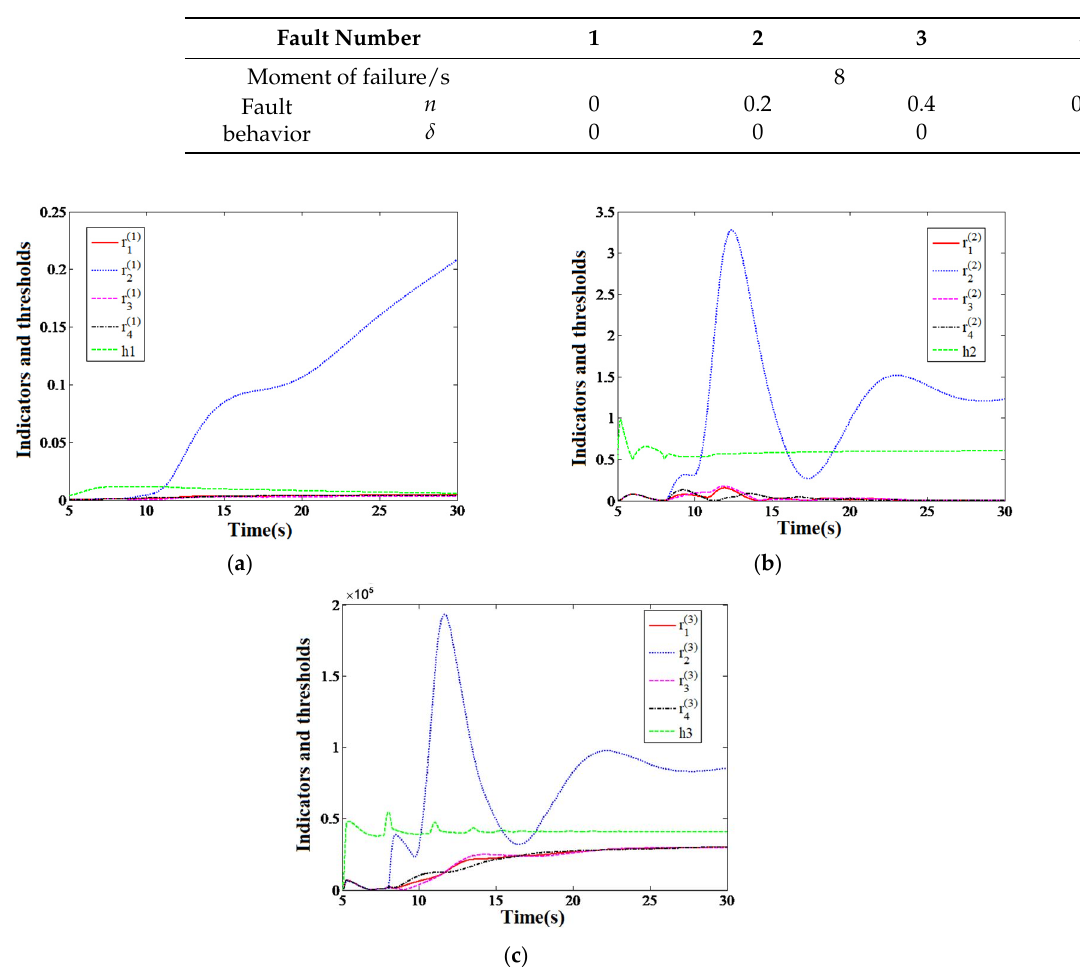
Figure 6. Changes of fault detection indicators under Fault 1: ( a ) Fault detection index r i (1) and threshold h1; ( b ) Fault detection index r i (2) and threshold h2; ( c ) Fault detection index r i (3) and threshold h3